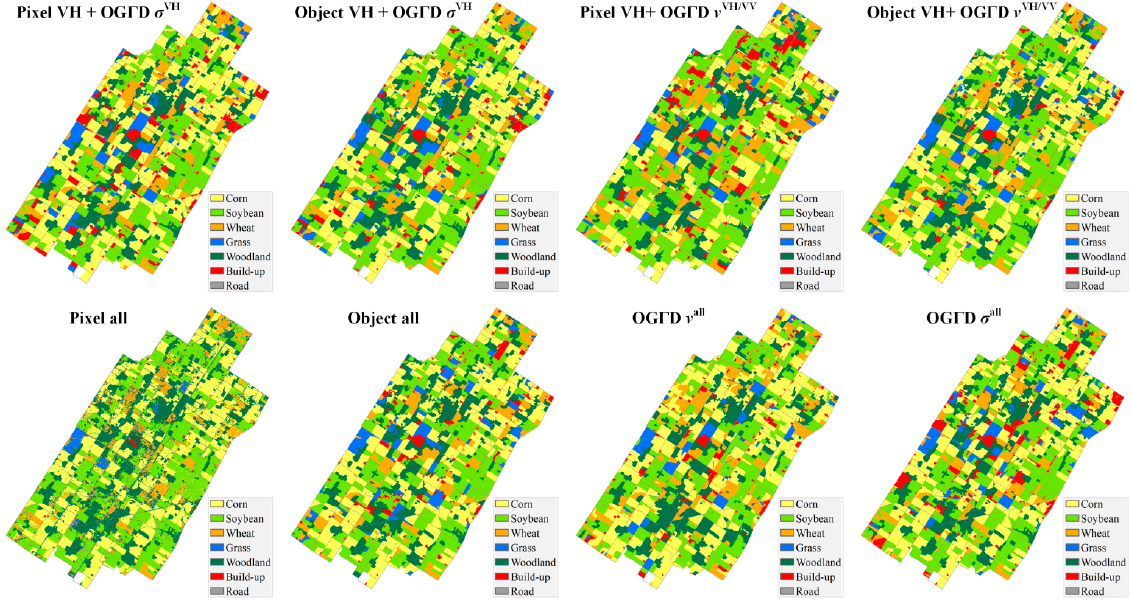
Figure 7. Crop classification results using feature combinations. The first row combines backscattering features and OG Γ Ds in the best-performance polarization channels. The second row combines different polarizations (VH, VV, and VH/VV) of the same type of features. Table 2. The quantitative evaluation results of crop classification using feature combinations. The superscript of all means three polarization channels (VH, VV, VH/VV) were